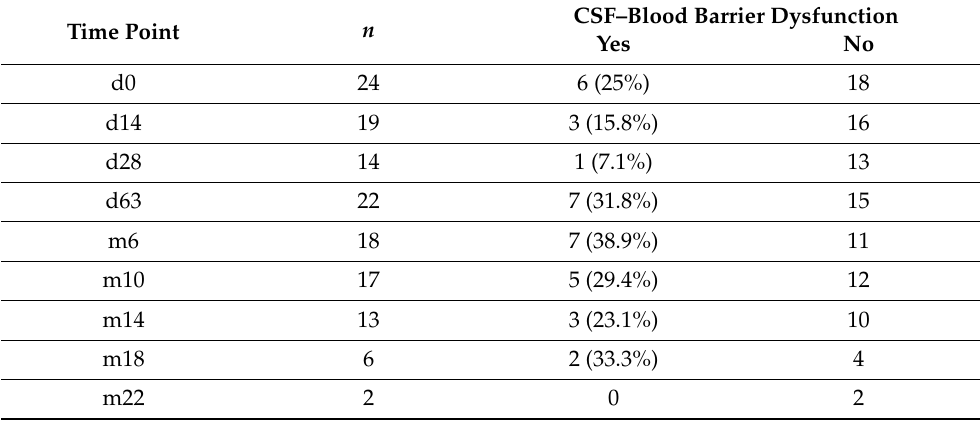
Table 3. SMA patients with or without CSF–blood barrier dysfunction according to age-adjusted reference levels for QAlbumin throughout therapy (d0 to m22). CSF: cerebrospinal fluid; d: day; m: month; SMA: spinal muscular